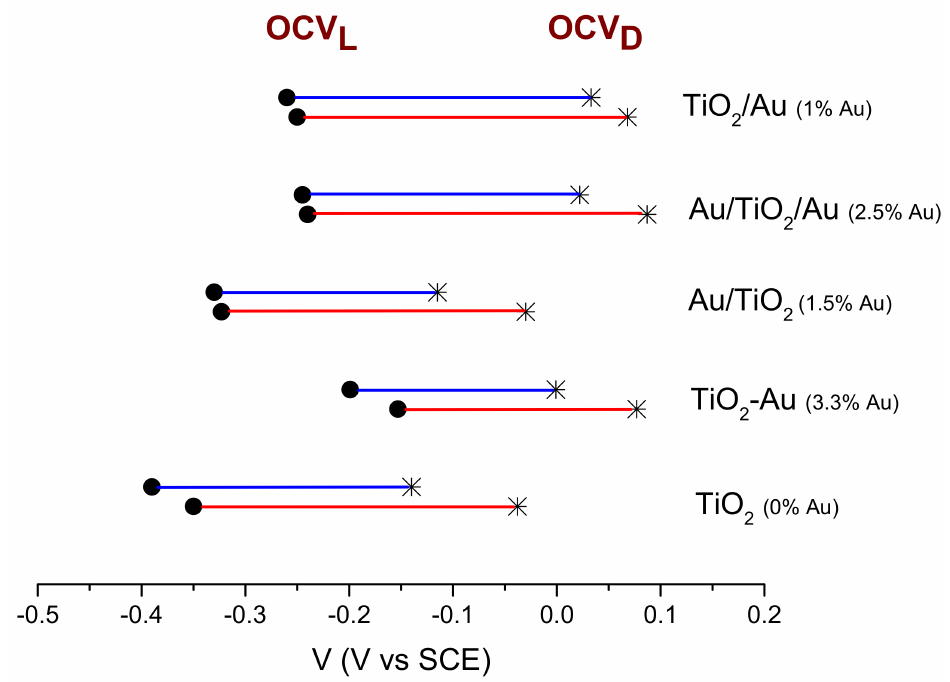
Figure 2. OCV of different samples, under dark (OCV D : stars) and irradiated (OCV L : circles) conditions, in supporting electrolyte (blue lines) or in the presence of 50 ppm BPA (red lines).